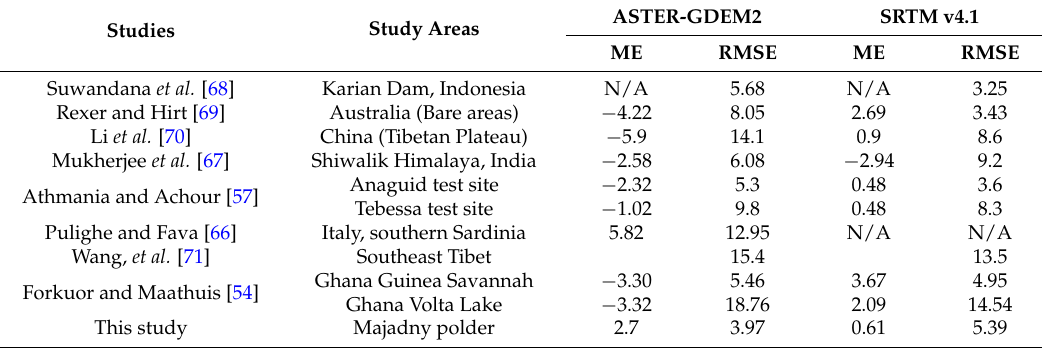
Table 4. Varying reported height accuracies for the ASTER-GDEM2 and SRTM-DEMs based on [57] and other publications (unit in